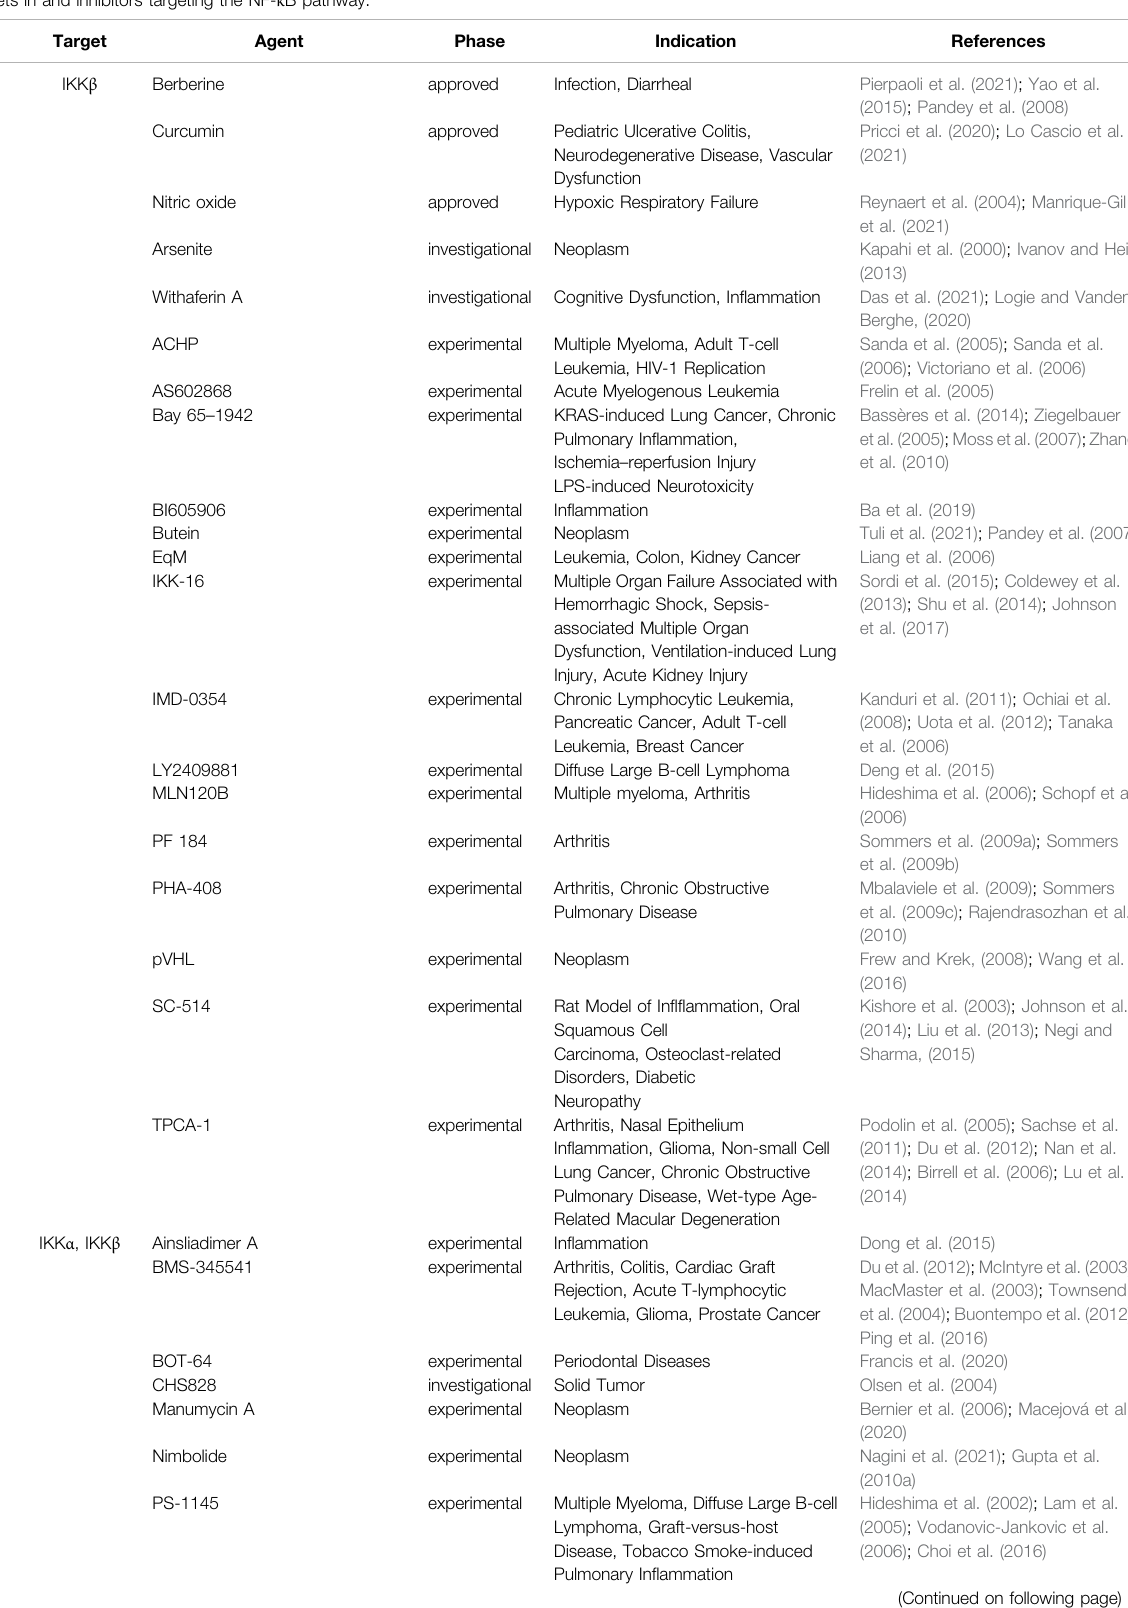
TABLE 2 | Targets in and inhibitors targeting the NF- κ B